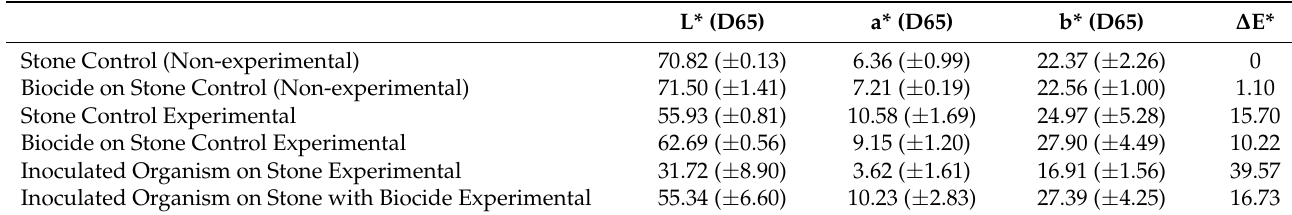
Table 2. Colorimetric analysis (n = 3) and standard deviation values of the stone replicas subjected to the carrageenan treatment and the growth of P. sesnandensis